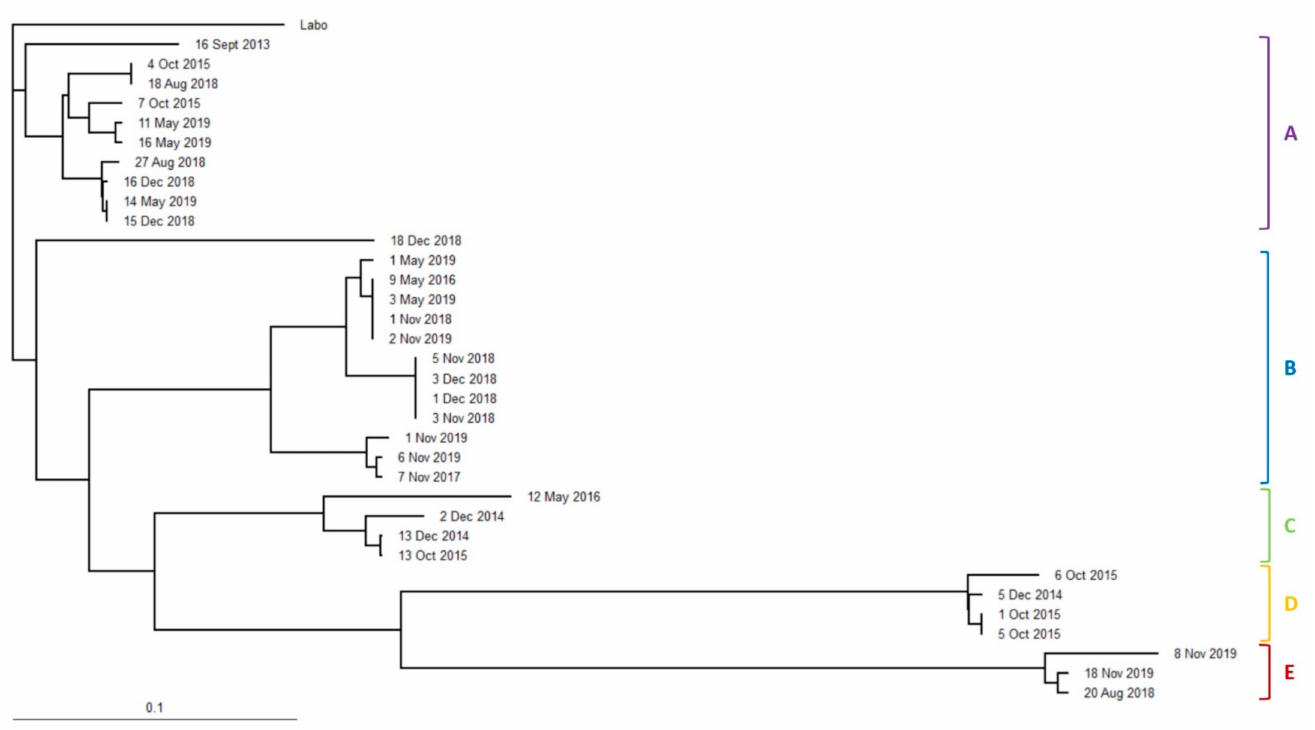
Figure 9. Dendrogram obtained using UPGMA among cohorts of Reticulitermes speratus collected at Kindai University. Cohorts from the same population are labeled A, B, C, D and